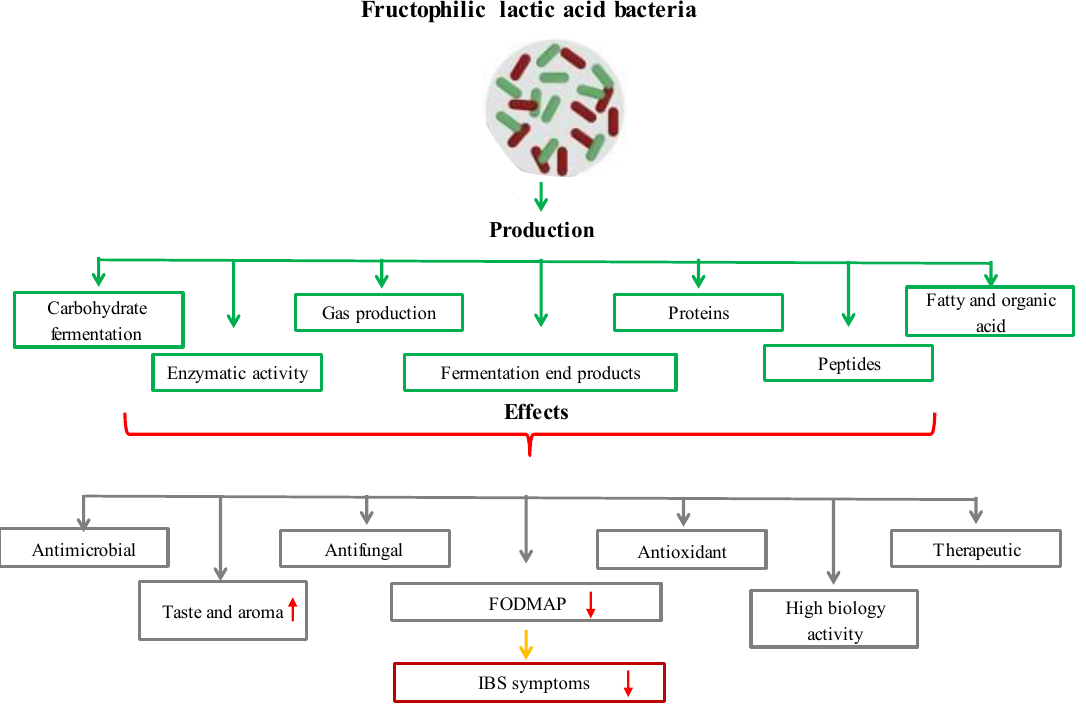
Figure 5. The effects of functional and metabolic properties of FLAB on health and food